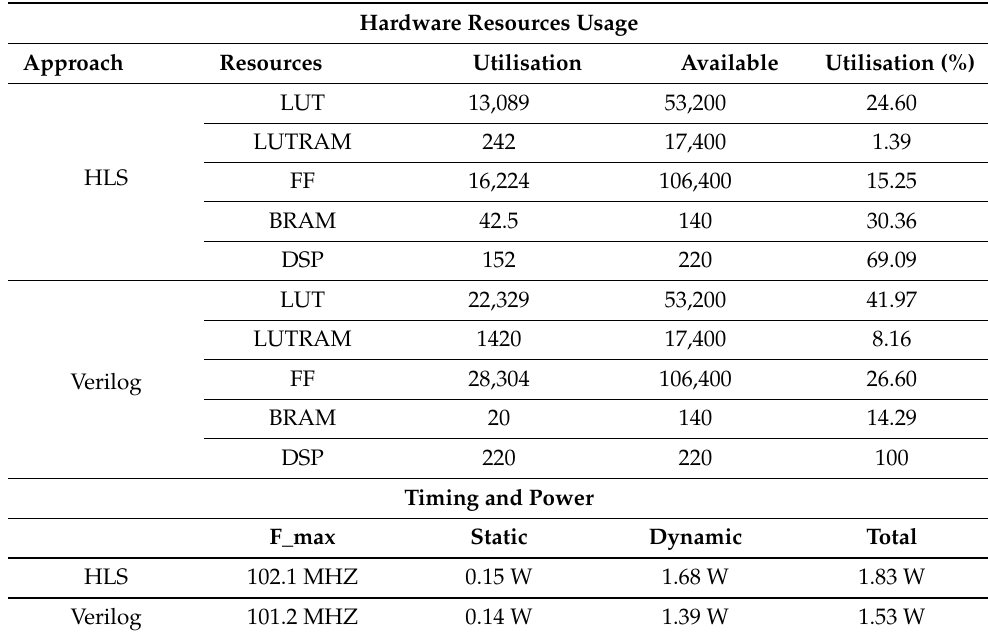
Table 6. The IoT-23 dataset implemented results on PYNQ-Z2 SoC